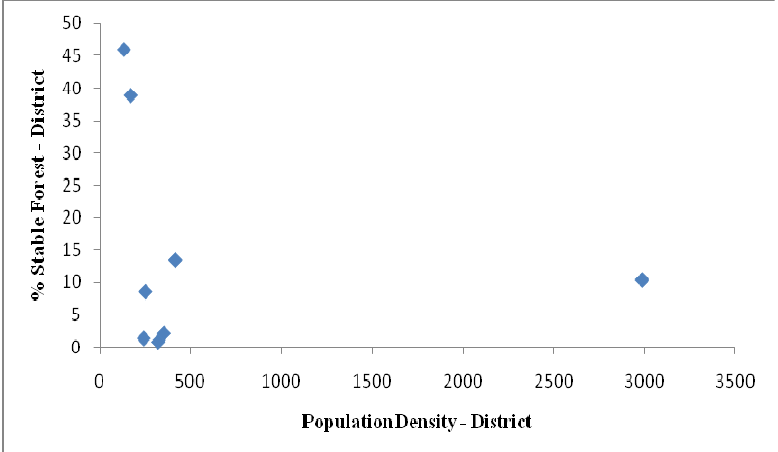
Figure 5a. Relationship between population density and the distribution of stable forest for districts.